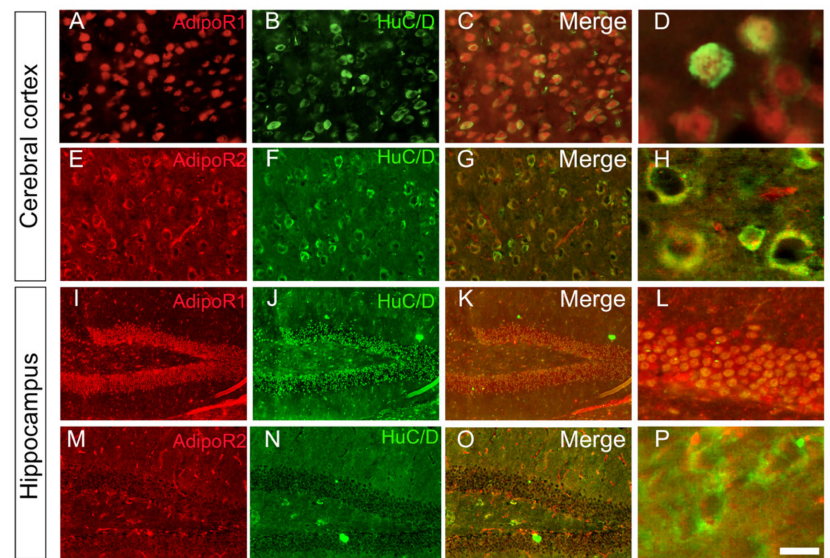
Figure 2. AdipoR1 and AdipoR2 are expressed by neurons in the cortex and hippocampus of mice. ( A ) AdipoR1 and ( E ) AdipoR2 immunostaining (red) with HuC/D neuronal co-labelling (green, ( B , F )) in the cerebral cortex demonstrating major co-staining (yellow, ( C , D , G , H )). ( I ) AdipoR1 and AdipoR2 ( M ) immunostaining (red) with HuC/D neuronal co-labelling (green, ( J , N )) in the dentate gyrus of the hippocampus. AdipoR1 is strongly expressed in neurons, as shown in the merge pictures (yellow, ( K , L )). Although AdipoR2 appears less expressed in the hippocampus, it co-localized with the neuronal marker (yellow, ( O , P )). Note that AdipoR2 is also detected in structures looking like blood vessels. ( D , H , L , P ) : Higher magnifications. Scale bar: 7 µ m ( D , H ), 14 µ m ( L , P ), 200 µ m ( A – G ) and 400 µ m ( I – O